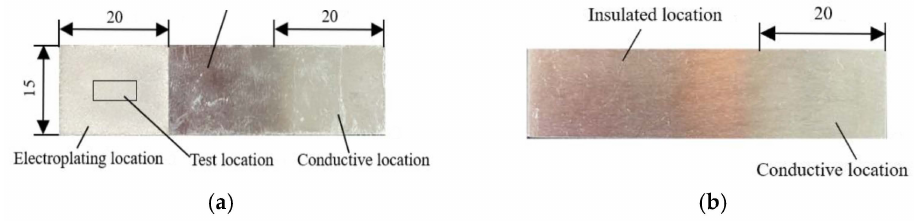
Figure 1. Schematic diagram of the substrate specification dimensions, seal location, plating area and test area: ( a ) front view and ( b ) back